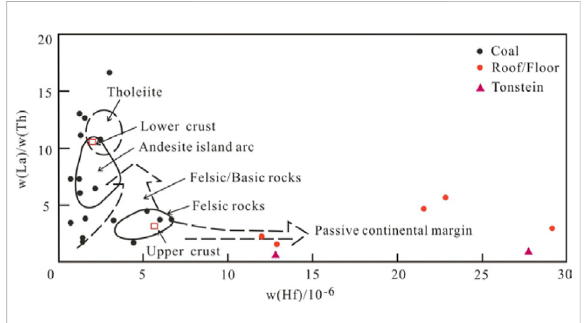
FIGURE 6 w (La)/ w (Th) — w (Hf) discrimination diagram for provenance attribute Data of Zr and Hf are cited from Shao et al.